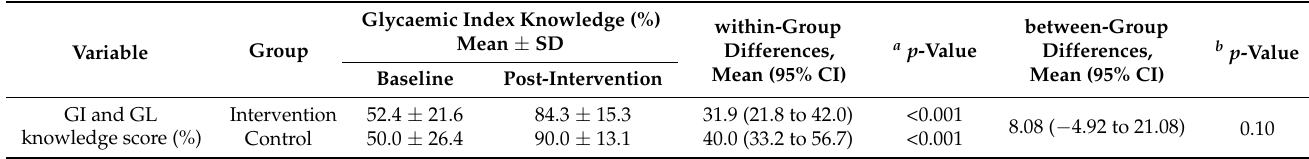
Table 3. GI and GL knowledge scores at baseline and post-intervention.